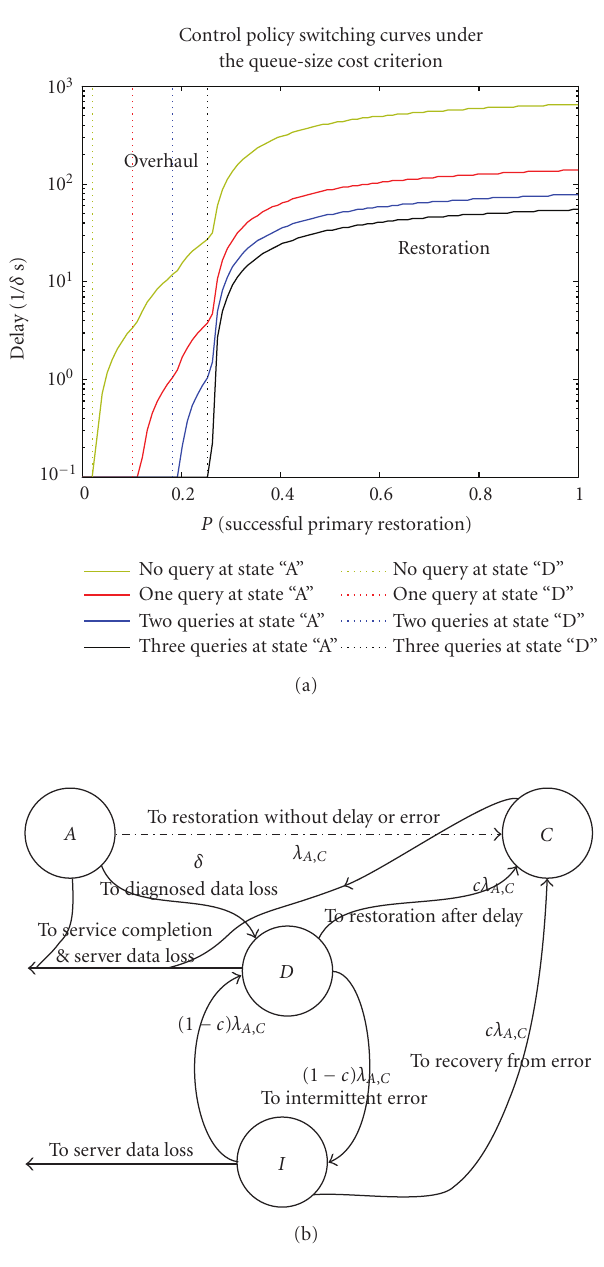
Figure 9: (a) Switching curves of the optimal policy under dis- counted queue size. (b) Partial database model containing both con- trol action delay and decision